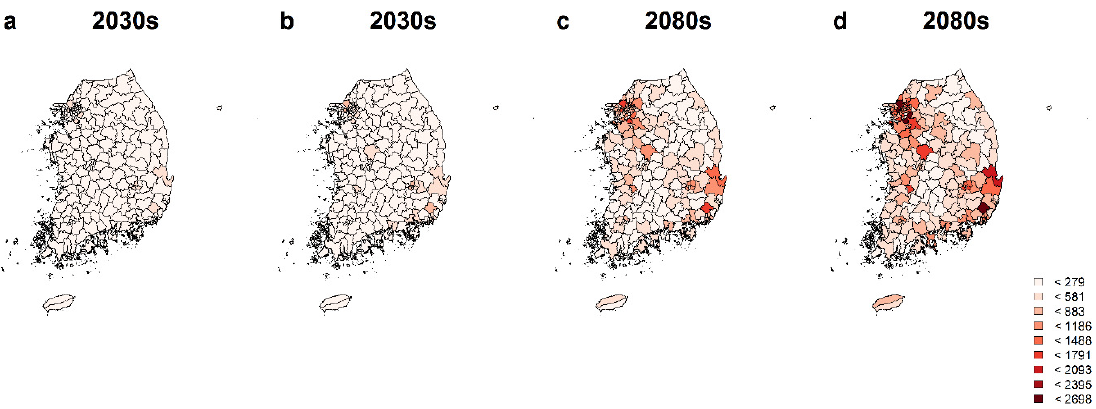
Figure 4. National distribution of temperature-attributable deaths considering simultaneous effects of PM 10 and temperature when PM 10 was assumed to be 35 μ g/m 3 , for ( a ) and ( c ), and 95 μ g/m 3 , for ( b ) and ( d ), under RCP8.5 in the 2030s and 2080s.